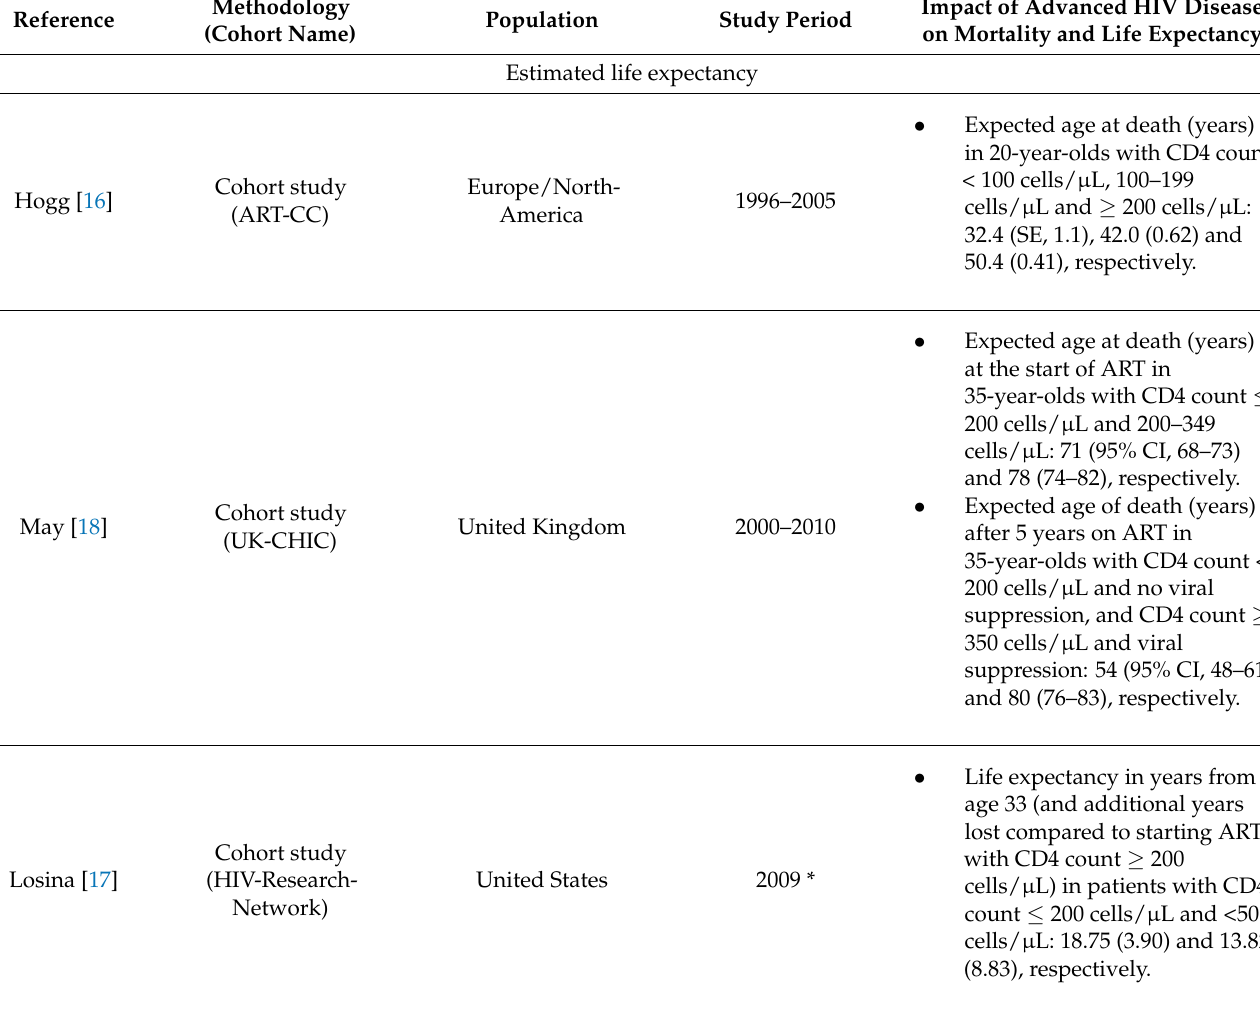
Table 1. Impact of advanced HIV disease on life expectancy and